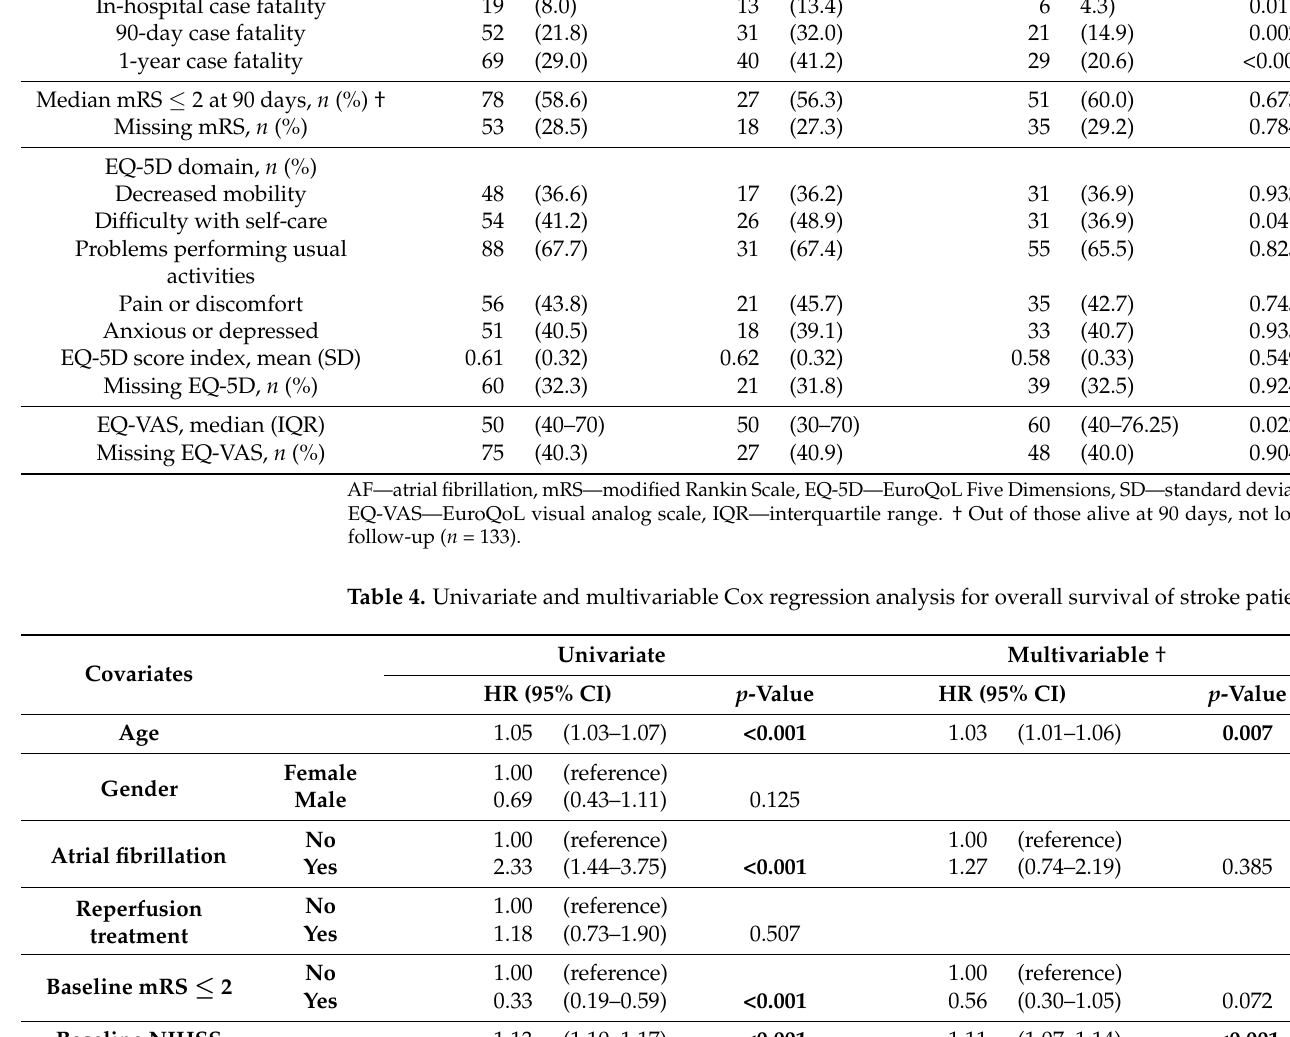
(Table 3). However, the EQ-5D-3L index scores did not differ significantly between groups. Although multivariate linear regression analyses showed that AF had a significant influence on EQ-VAS ( β ± SE: − 11.776 ± 4.850, p = 0.017), no such influence was demonstrated for the EQ-5D-3L index score ( β ± SE: − 0.013 ± 0.060, p = 0.833), when adjusted for age, gender, presence of reperfusion treatment, baseline good functional status, and